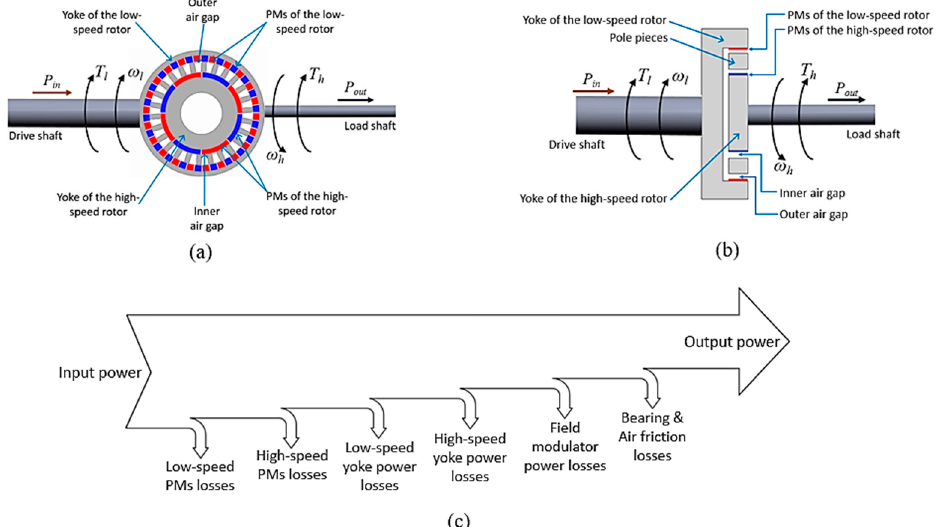
Figure 13. Essential elements of an MG for the transmission of mechanical torque: ( a ) Elementary schematic of a transmission system based on a Coaxial MG; ( b ) Basic components of the Coaxial MG; ( c ) Power losses in a Coaxial MG.